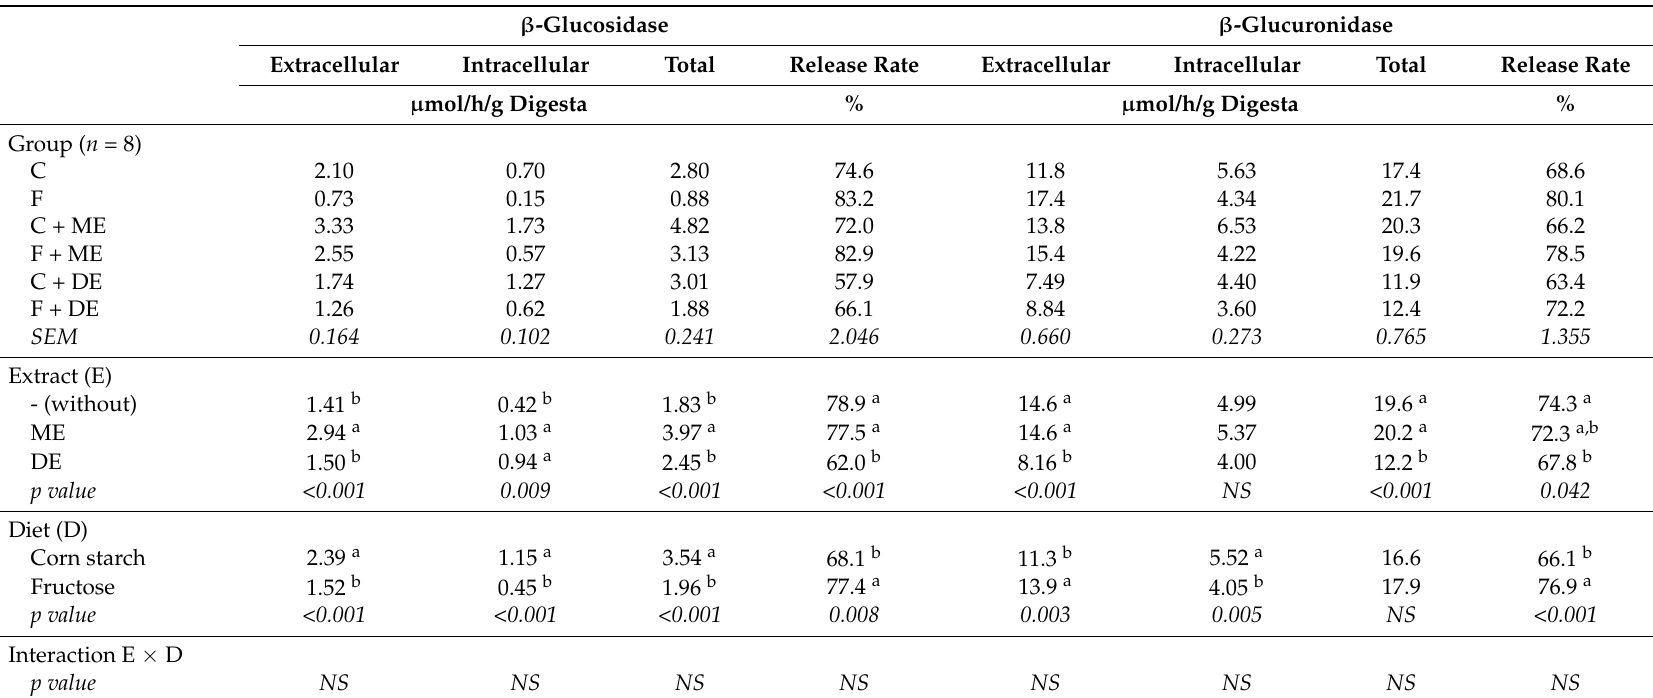
Table 4. Activity of cecal bacterial enzymes and their release rate into the intestinal environment in rats *. β -Glucosidase β